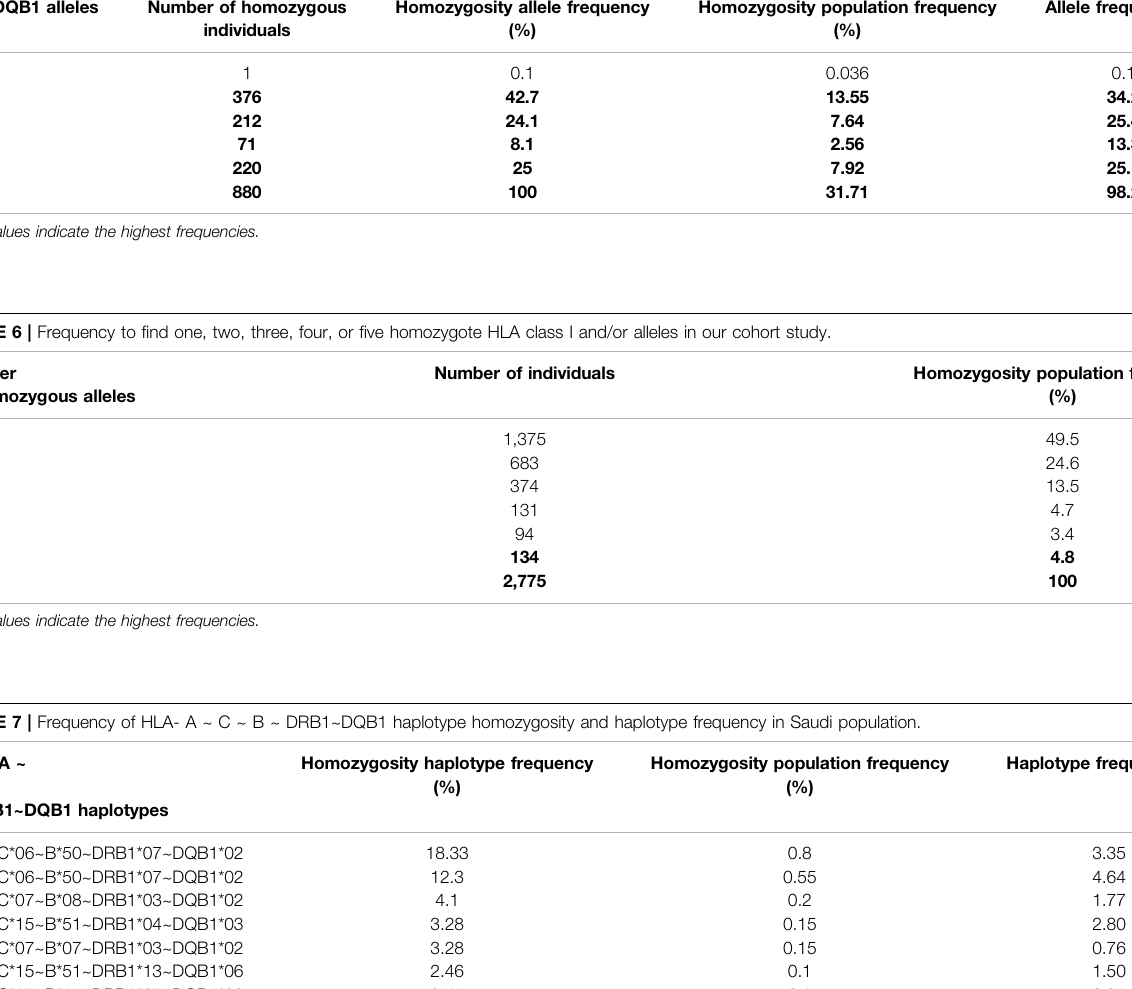
TABLE 5 | List of HLA-DQB1 alleles detected in locus DQB1 and the frequency of homozygosity and allele frequencies. HLA-DQB1 alleles